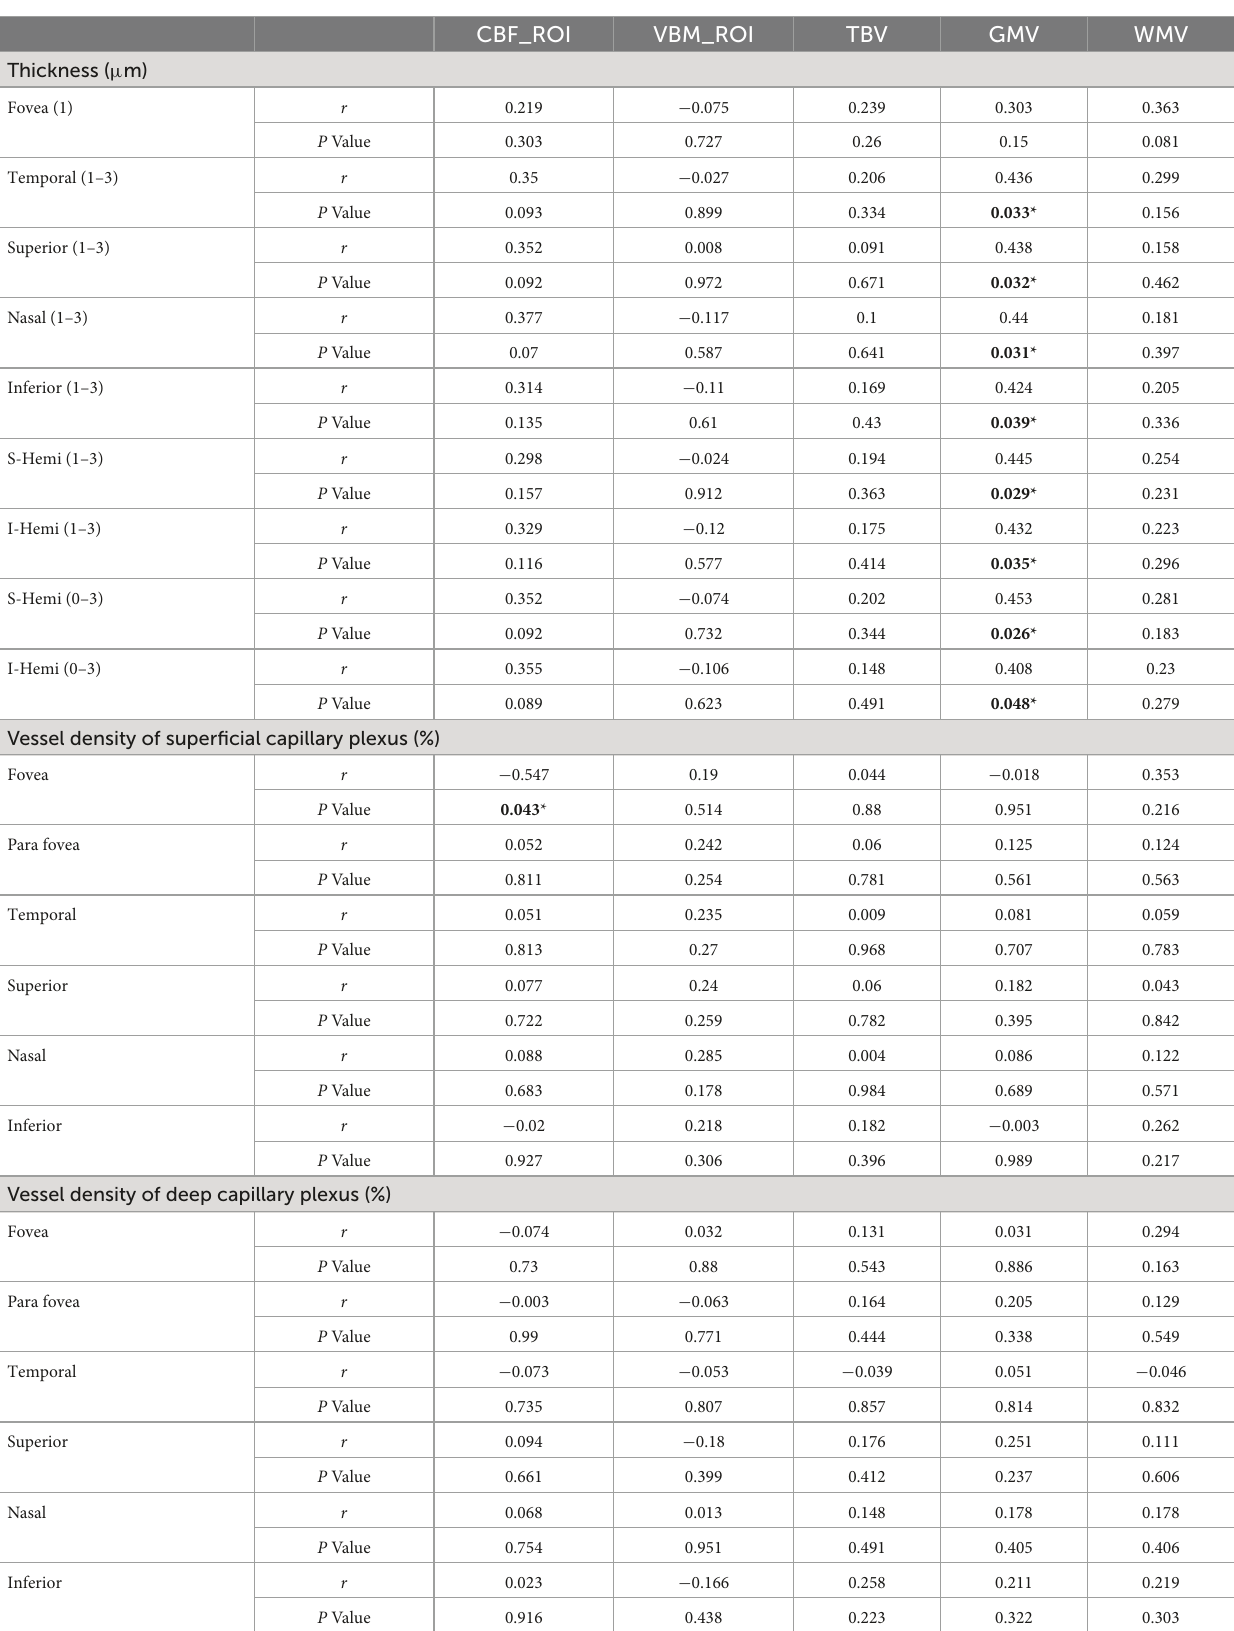
TABLE 3 Partial Spearman correlation analysis of neuroimaging and macular parameters in mild AD group with adjustment for age, gender, education, and